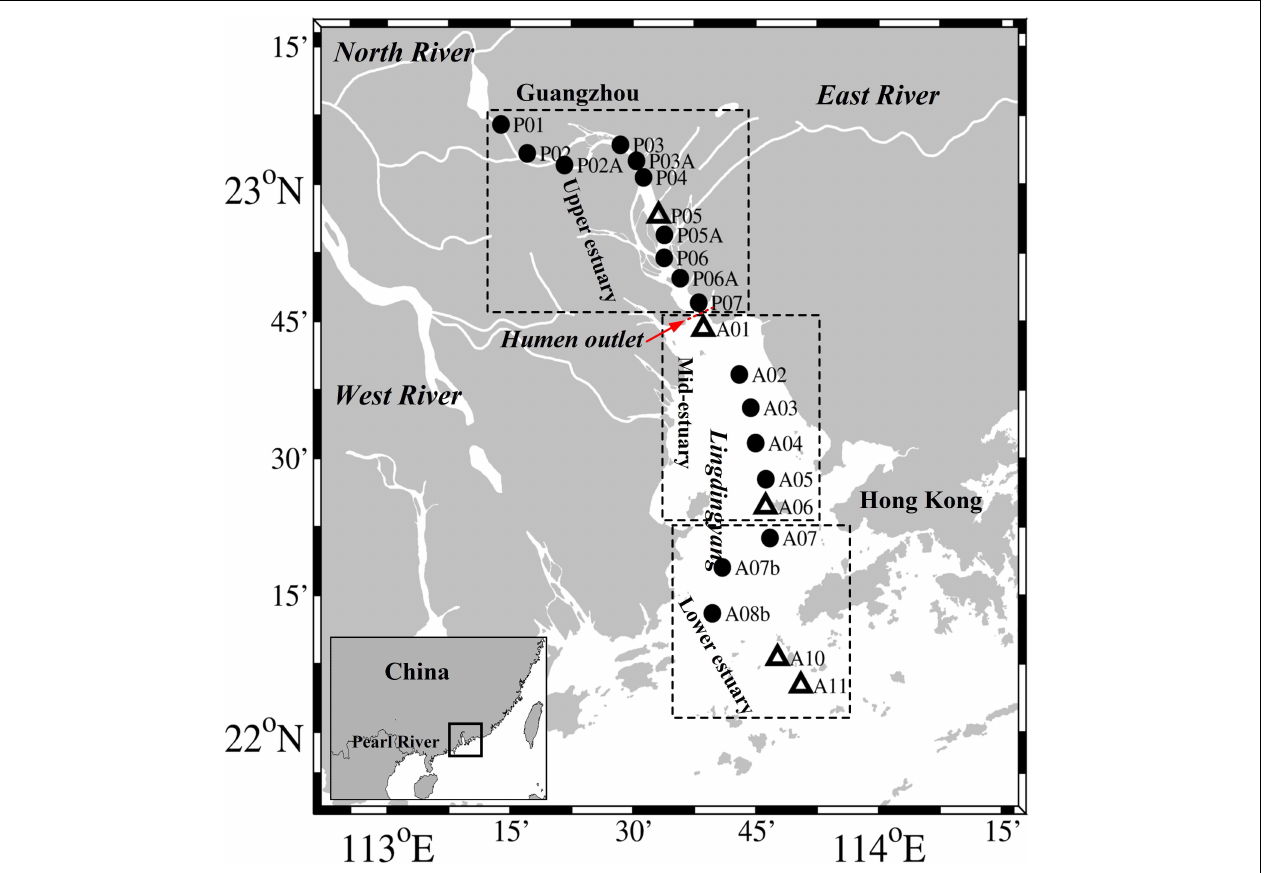
FIGURE 1 | Map of the Pearl River estuary and the sampling sites in July 2014. The dotted boxes separate the study sites into the upper, mid, and lower estuarine regions. The open triangles represent the sites (P05, A01, A06, A10, and A11) where we conducted size fractionation